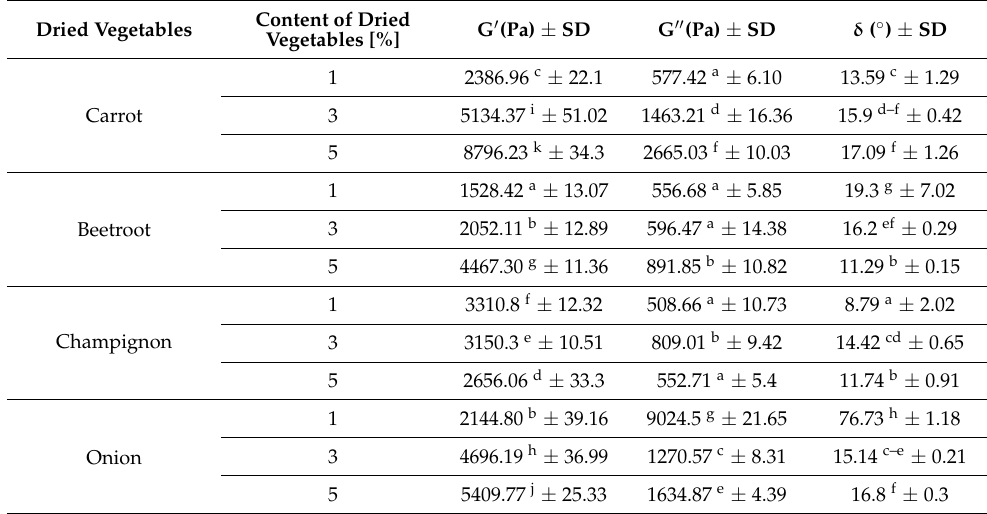
Table 3. Effect of different amounts of dried vegetable powders on phase angle δ ( ◦ ), storage (G (cid:48) ), and loss (G (cid:48)(cid:48) ) moduli of fat-free dairy desserts. Dried Vegetables Content of Dried Vegetables [%] G (cid:48) (Pa) ± SD G (cid:48)(cid:48) (Pa) ± SD δ ( ◦ ) ± SD